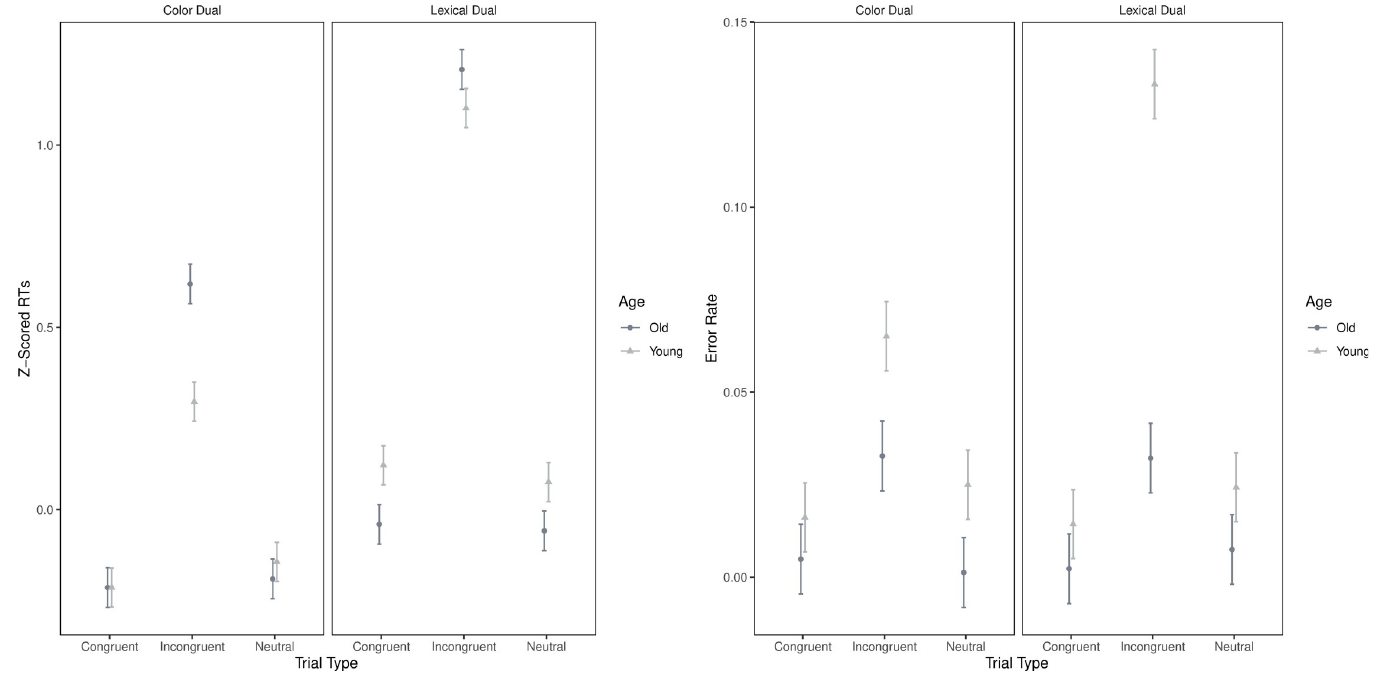
Fig 3. A. Z-scored response times for dual-task type, trial type, and age. B. Error rates for dual-task type, trial type, and age.